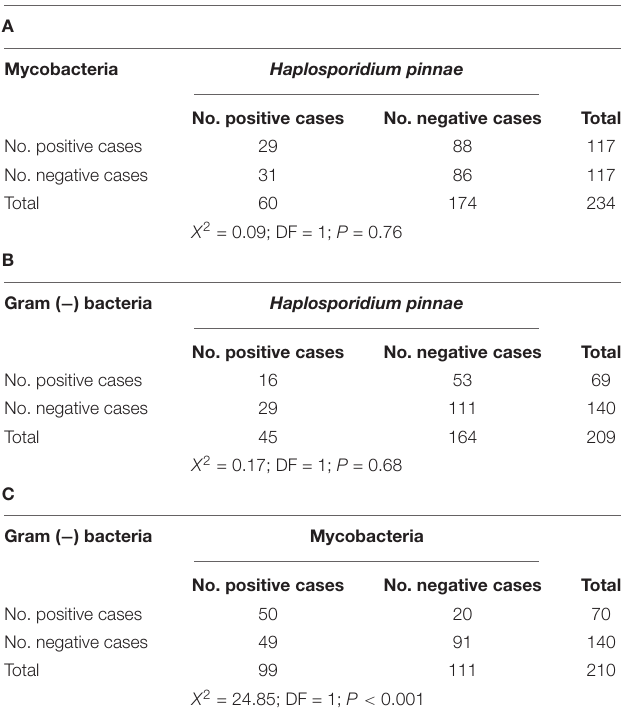
TABLE 5 | Contingency tables and statistical test to evaluate the association between the occurrence of Haplosporidium pinnae and that of mycobacteria (A) , H. pinnae and Gram ( − ) bacteria (B) , and mycobacteria and Gram ( − ) bacteria (C)